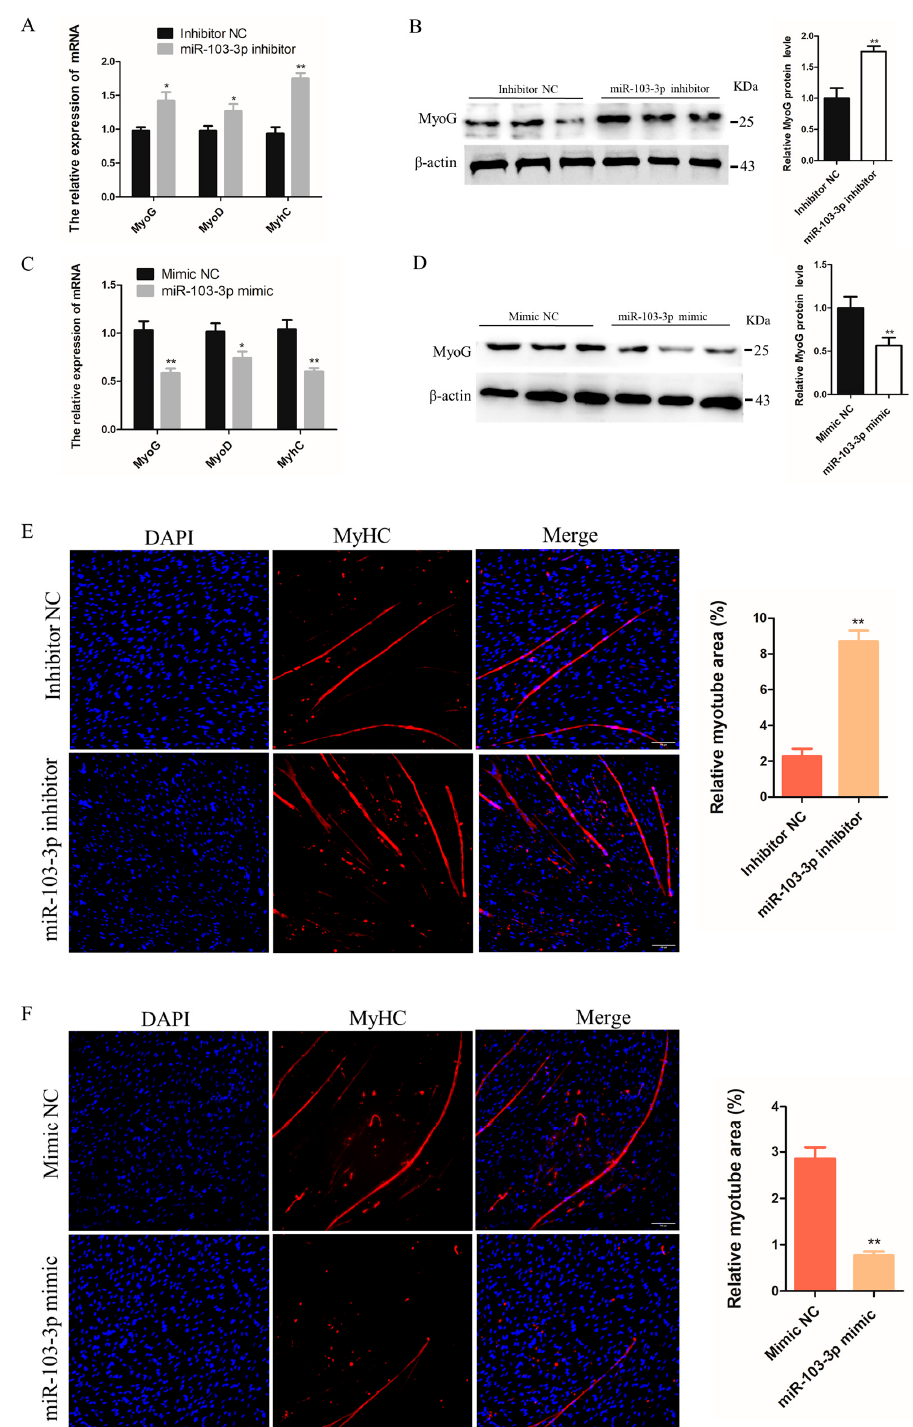
Figure 2. miR-103-3p inhibited the differentiation of C2C12 cells. ( A , C ) The mRNA expression of MyoG , MyoD , and MyHC in C2C12 cells was determined by qRT-PCR at 24 h after transfection with the miR-103-3p inhibitor or mimic. n = 3. ( B , D ) The protein expression of MyoG in C2C12 cells was determined by western blot at 48 h after transfection with the miR-103-3p inhibitor or mimic. β -Actin was used as the endogenous control. n = 3 ( E , F ) C2C12 cells were induced to differentiate for 48 h. Anti-MyHC immunofluorescence staining was performed in C2C12 cells at 48 h after transfection with the miR-103-3p mimic or inhibitor, and the relative myotube area was measured following miR-103-3p knockdown and overexpression. Scale bar = 100 µ m. n = 3. * p < 0.05, ** p <